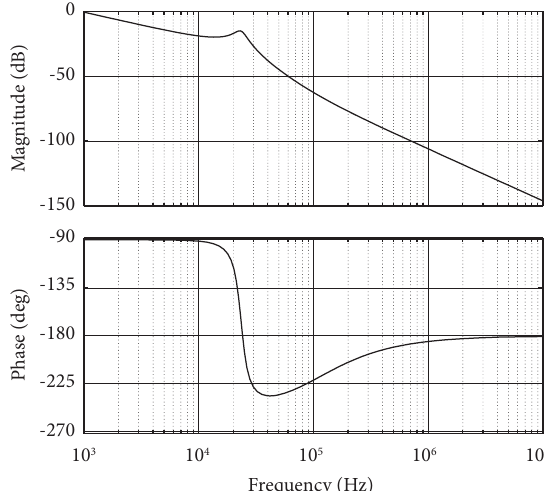
Figure 9: LCL flter diagram after parameter design.